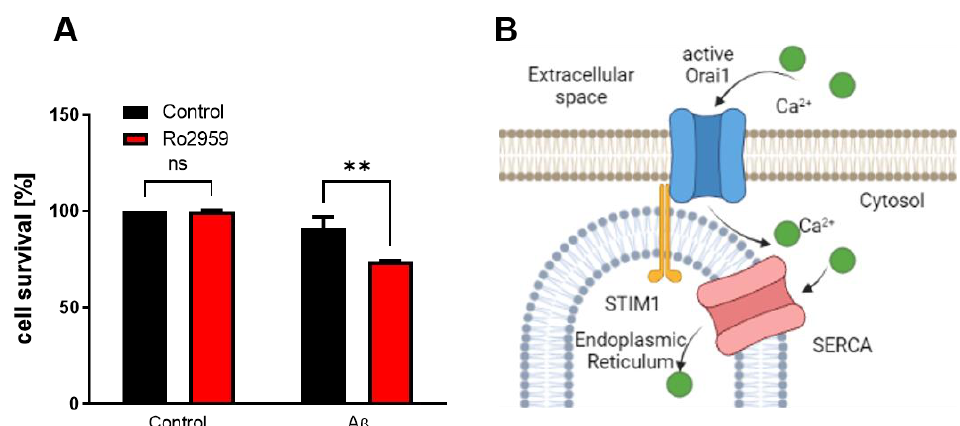
Figure 8. SURF4 affects SOCE proteins. ( A ) Neuroblastoma cells were treated with 10 µ M oA β 1–42 in the presence of the SOCE inhibitor Ro for 24 h. Data are the mean ± SEM of 3 independent experiments. ** p < 0.01, non-significant (ns) vs. the respective controls by ANOVA plus Bonferroni as post-hoc test. ( B ) SOCE is dependent in the interaction of STIM, located in ER, with ORAI, located in the plasmatic membrane that opens to allow the entrance of calcium.